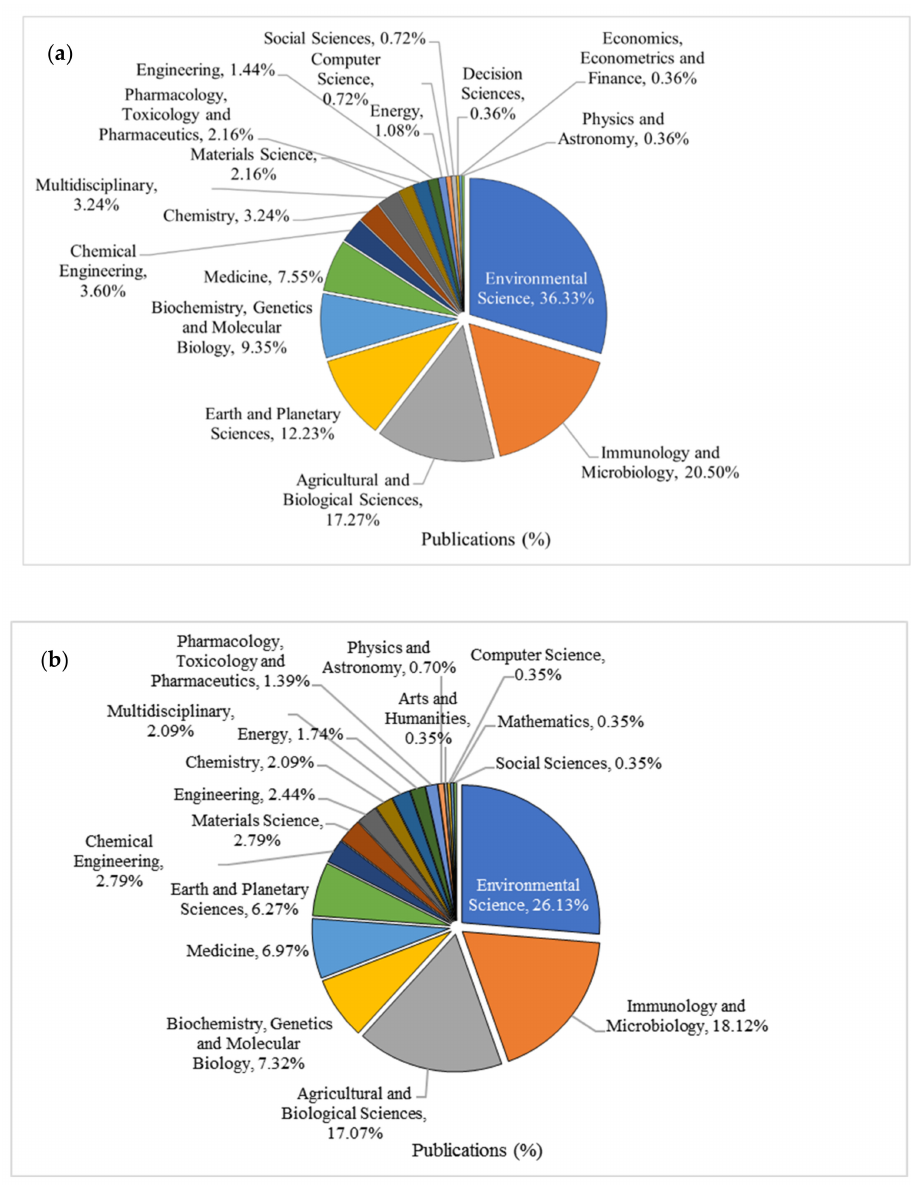
Figure 4. Distribution of publications by various subject areas based on the hydrocarbon degradation by microbial community in marine environments of ( a ) Arctic and ( b )